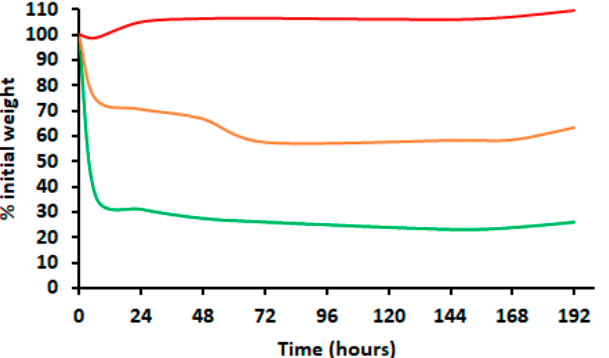
Figure 6. Percentages of the initial weights measured after evaporation of A. pusilla EO formulations at room temperature (means of 25 °C) for 192 h. Green line = AP-EO, free essential oil of A. pusilla. Orange line = AP-EO/MSPs, essential oil of A. pusilla encapsulated in mesoporous silica particles. Red line = AP-EO/MSPs-Chi, essential oil of A. pusilla encapsulated in mesoporous silica particles coated with chitosan.